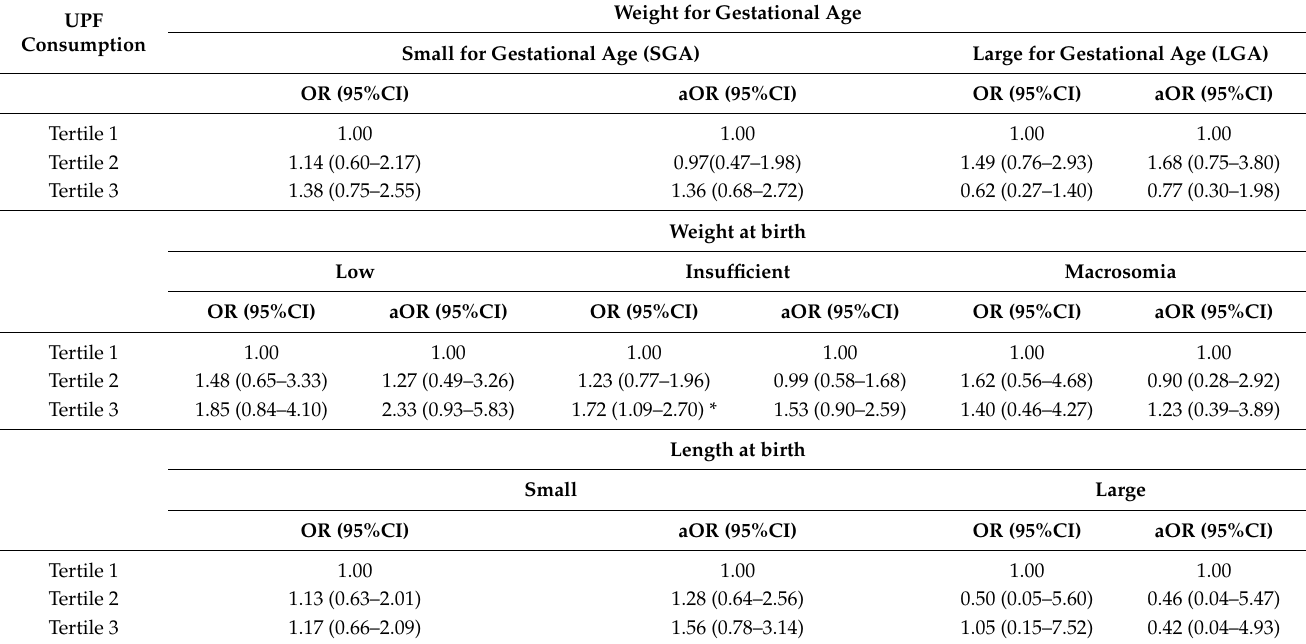
Table 2. Unadjusted and adjusted odds ratio for ultra-processed foods consumption tertiles during pregnancy associated with the anthropometric measurements of the baby, according to logistic regression